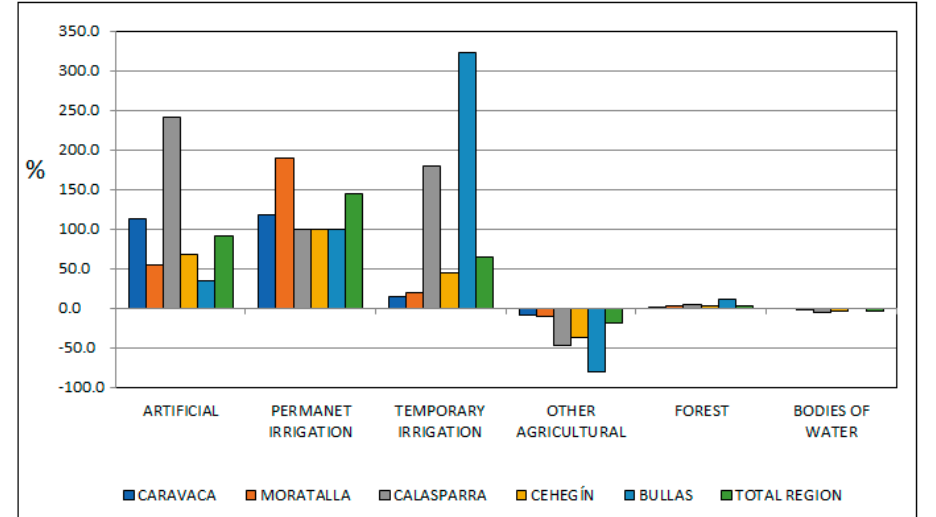
Figure 9. Evolution of the surface occupied by coverage and land use (1990–2018). Source: Corine Land